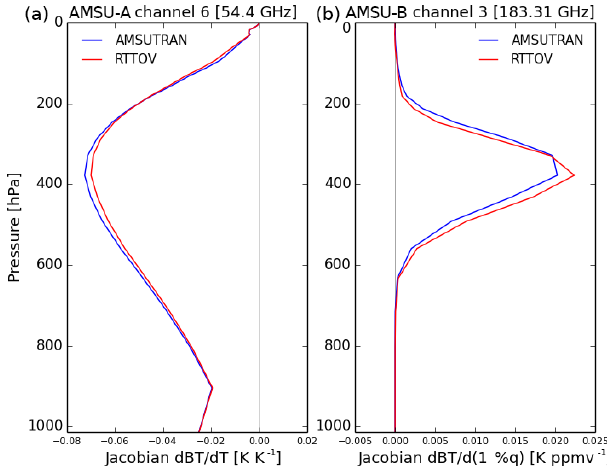
Figure 5. Temperature Jacobian for AMSU-A channel 5 (a) and water vapour Jacobian for AMSU-B channel 3 (b) for U.S. Standard Atmosphere (1976). AMSUTRAN (blue) is from the line-by-line code, and RTTOV (red) uses the RTTOV predictors to compute the transmittances for the